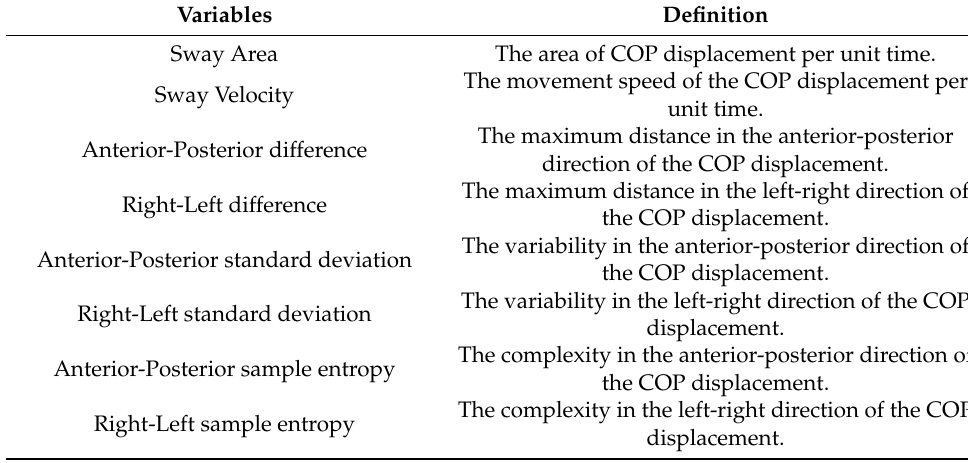
Table 1. Balance ability